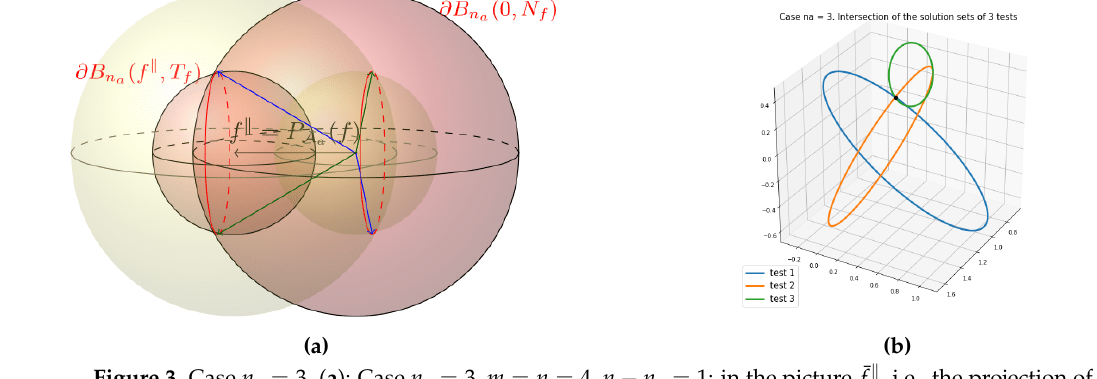
Figure 3. Case n a = 3. ( a ): Case n a = 3, m = n = 4, n − n a = 1: in the picture ¯ f (cid:107) , i.e., the projection of f on A a . The decompositions that satisfies the conditions on I f and N f are the ones with f a that lies on the red circumference on the left. The spheres determined by the conditions are shown in yellow for the vector f a and in blue for the vector f (cid:107) − a a . Two feasible decompositions are shown in blue and green; ( b ): Case n a = 3. Intersection of three hyperellipsoids, set of the solutions x a of three different tests, in the space R n a = 3 .